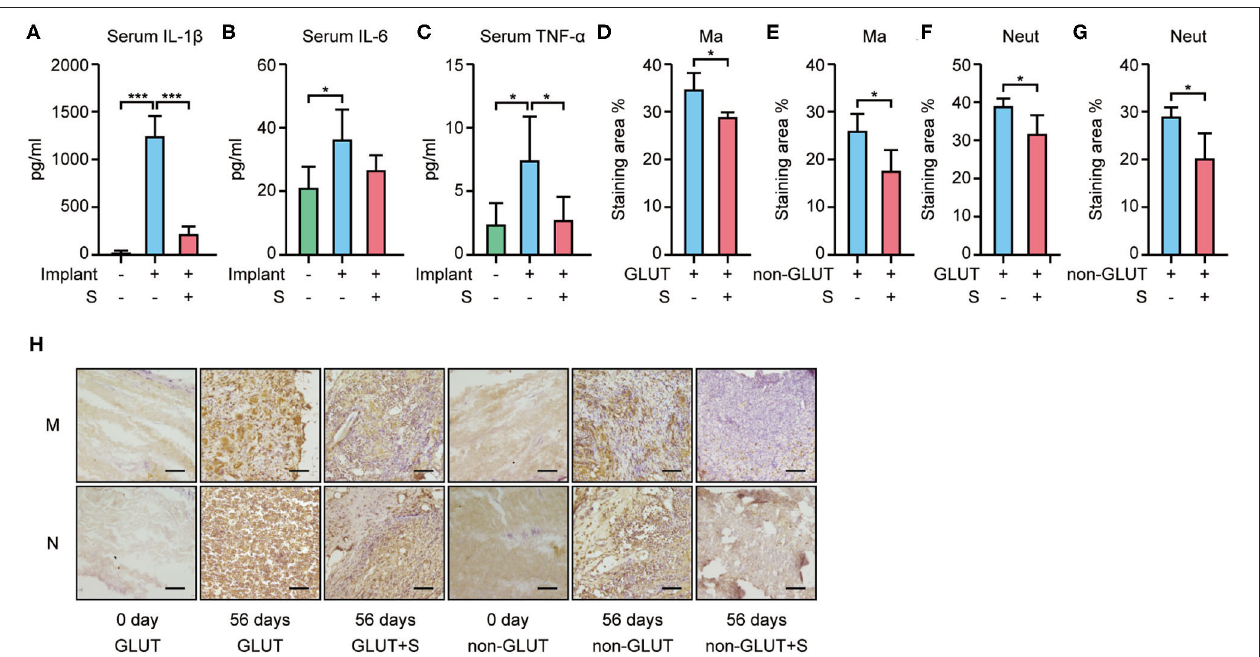
FIGURE 5 | Inflammatory markers in serum and macrophage/neutrophil infiltration in BHVs in implant and implant + S groups 56 days after implantation. (A–C) Serum level of IL-1 β (A) , IL-6 (B) , and TNF- α (C) increased in the implant group and attenuated by sevelamer. (D–H) Macrophage and neutrophil infiltration in BHVs and attenuated by sevelamer, and representative images (H) and quantification analysis of IHC staining; scale bars represent 100 µ m (D–G) . GLUT represents GLUT BHVs in the implant group, GLUT + S represents GLUT BHVs in the implant + S group, non-GLUT represents non-GLUT BHVs in the implant group, and non-GLUT + S represents non-GLUT BHVs in the implant + S group. M/Ma represents macrophage, and N/Neut represents neutrophil. N = 4, data are mean ± SD, * p < 0.05, *** p < 0.001.